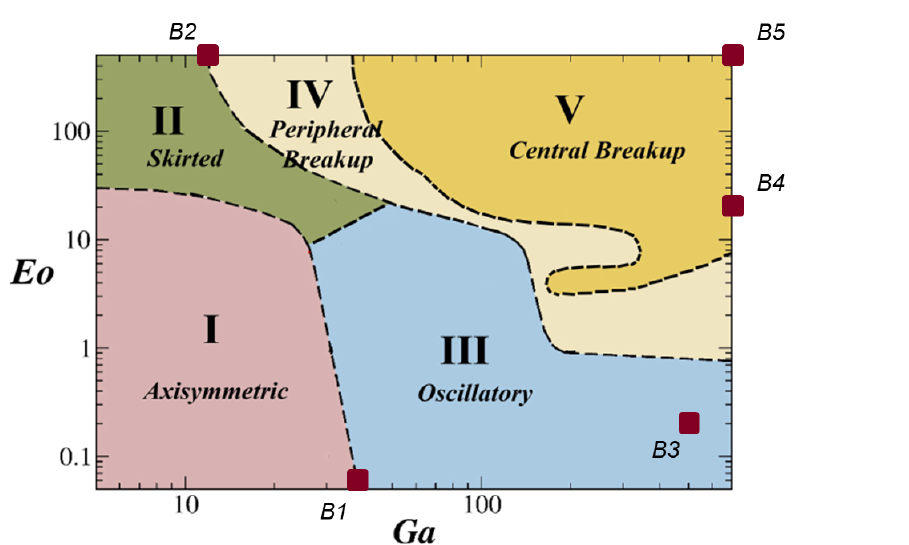
Figure 14. Water-air phase plot showing different regions of bubble behaviours, adapted from Ref.